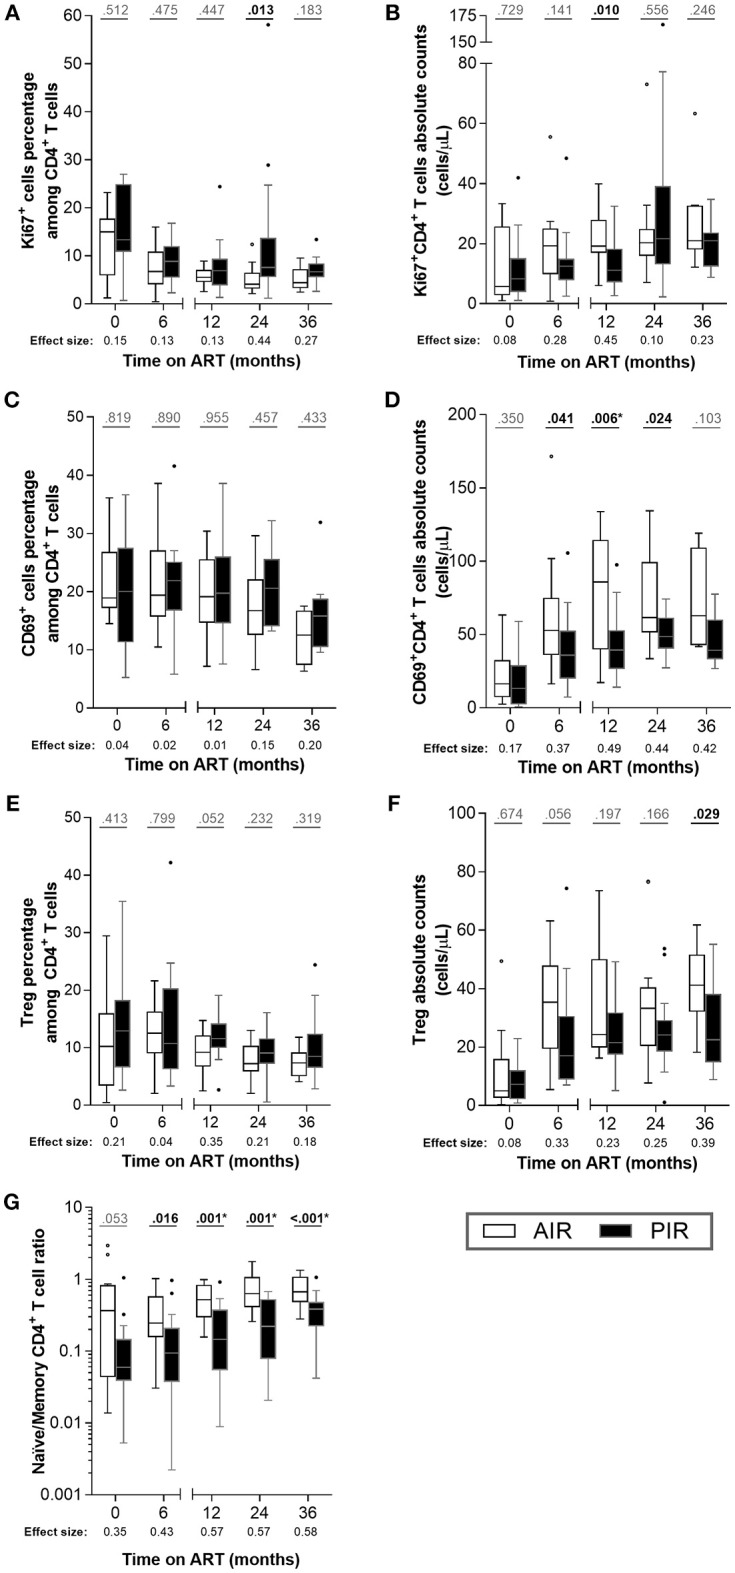
Throughout ART, PIR and AIR presented no major differences in CD4+ T cell activation status, proliferation, Treg numbers, nor naïve/memory CD4+ T cell ratio. (A) The percentage among CD4+ T cells and (B) absolute number of Ki67+ cells, (C,D) CD69+ cells, (E,F) Treg (CD25highCD127−FoxP3+CD4+ T cells) and (G) naïve/memory CD4+ T cell ratio were compared throughout therapy in AIR and PIR. A Wilcoxon-Mann-Whitney U-test was performed to compare the two groups of patients at each time point, and the corresponding r is presented as a measure of effect size. *Significant after Bonferroni correction (α/5 = 0.010).